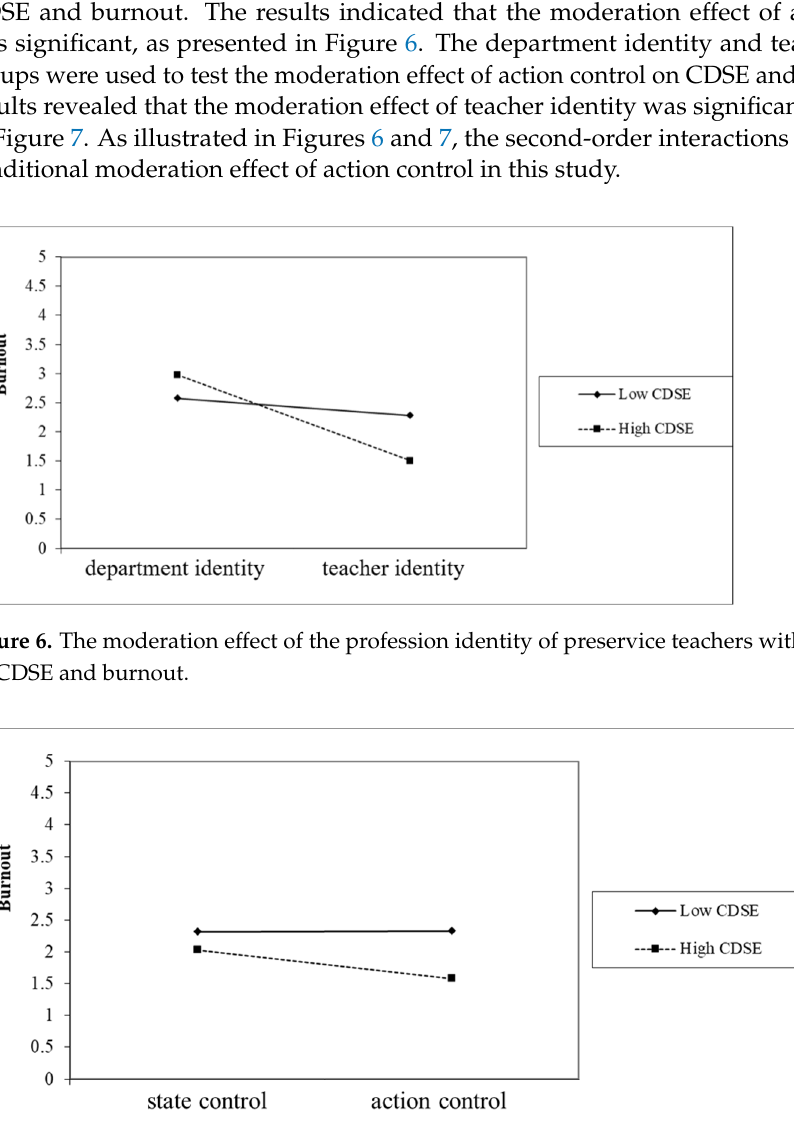
Figure 5. The moderation effect of profession identity on the relationship between CDSE and burn- out.